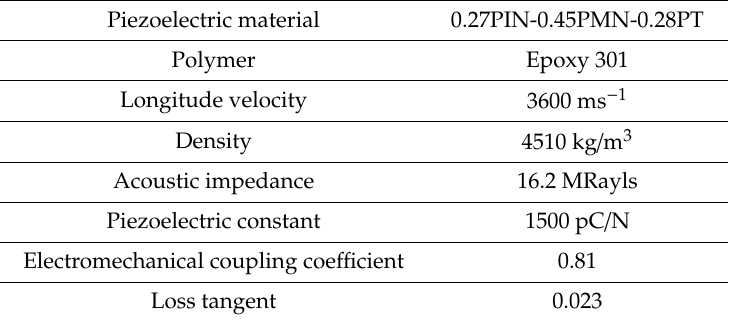
Figure 1. Schematic of the modified dice-and-fill method used for phased array fabrication. Table 1. Properties of piezoelectric single crystal 1-3